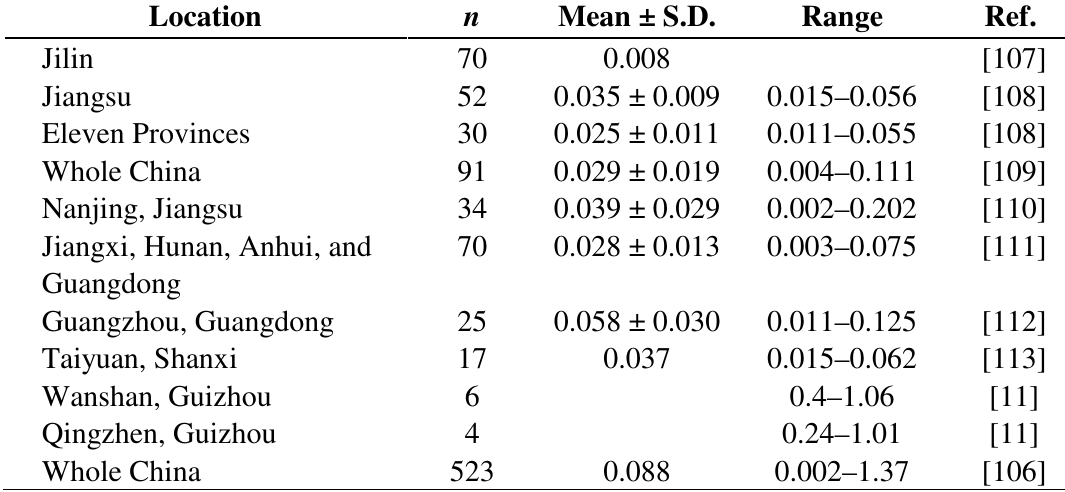
Table 4. The comparison of Se concentrations in rice in China/µg·g −1